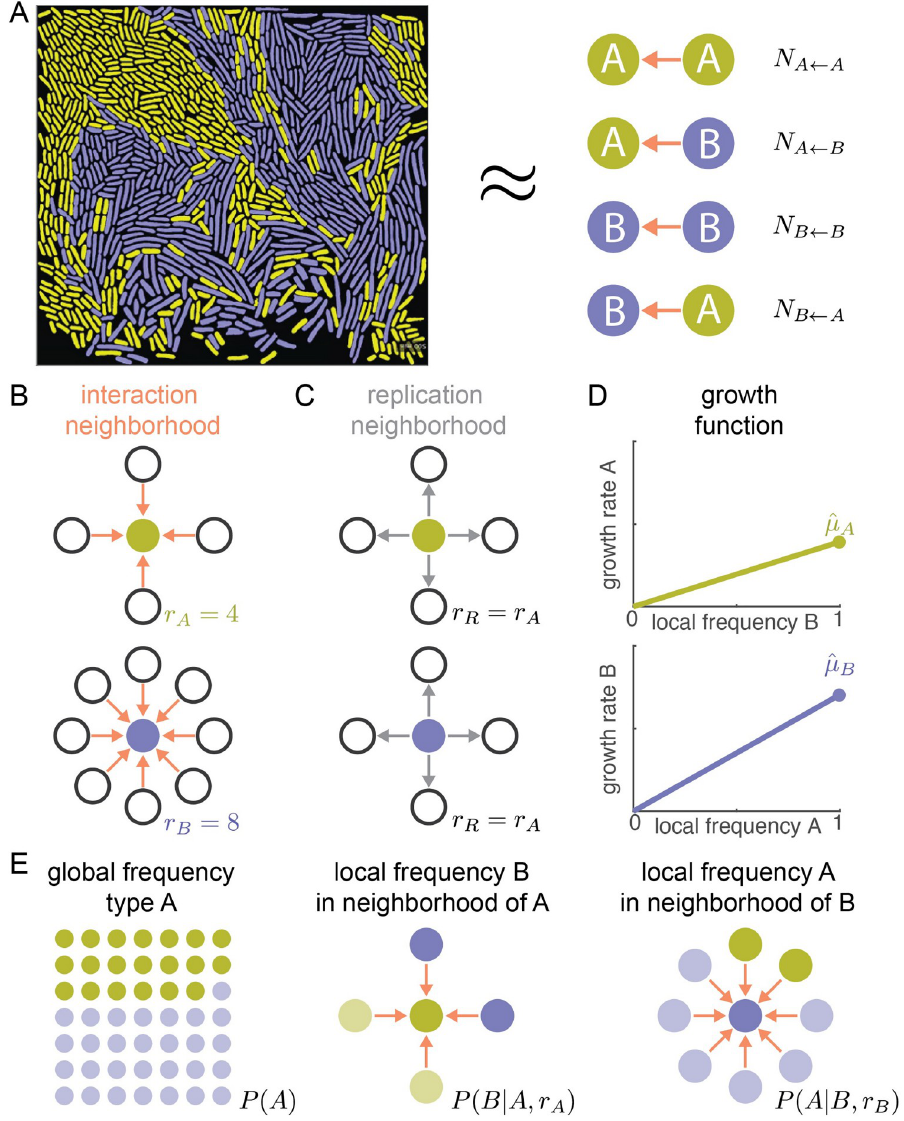
Fig 2. Pair approximation allows for a quantitative description of spatial systems. (A) Pair approximation assumes that a system of entities living in space and interacting with others close by (left side) can be fully described by tracking the number of all pairwise links between entities (right side). For example, a link counted in N indicates that focal X Y cell X interacts with its neighbor Y. (B-D) A system is fully described by: (B) the interaction neighborhoods of both types, characterized by the neighborhood sizes r and r ; (C) the replication neighborhood, assumed to be identical to A B the smallest interaction neighborhood; and (D) the growth functions of both types, characterized by the maximum growth rates ^ m and ^ m . (E) Pair approximation has three dynamical variables that describe the global composition, A B P ( A ), and local composition P ( B | A , r A ) and P ( A | B , r B ) of the